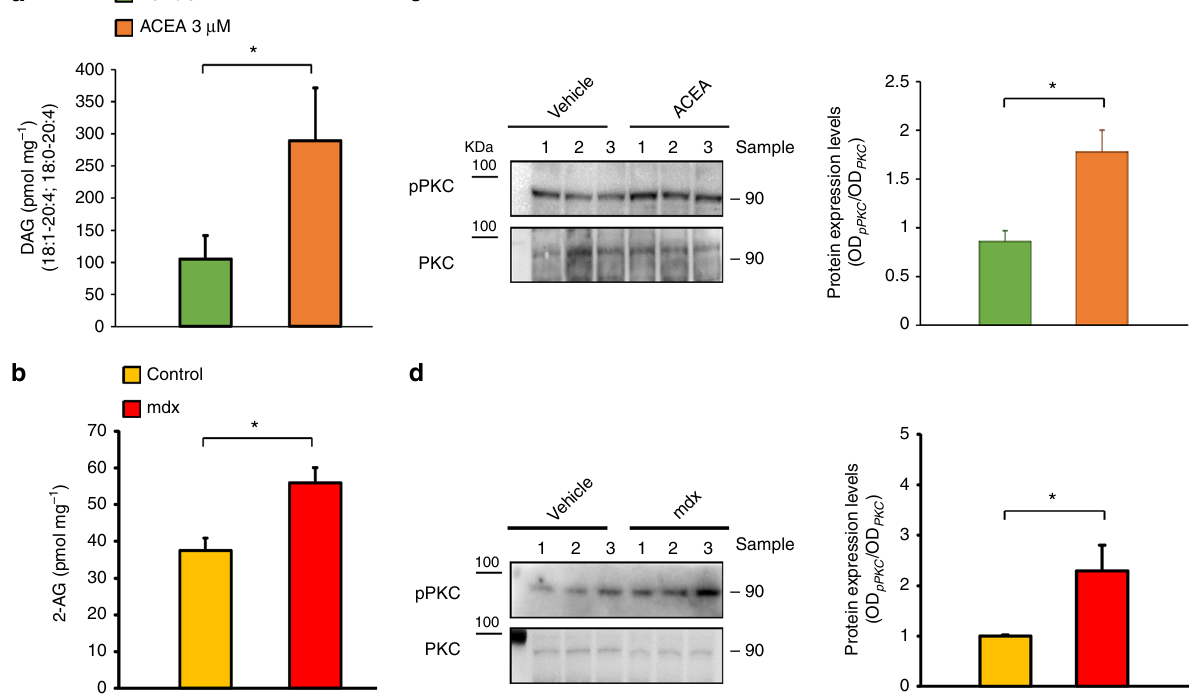
Fig. 9 Measurement DAGs levels and activity in satellite cells and muscles. Levels of diacylglycerols (DAGs) ( a ) and 2-AG ( b ), in primary satellite cells exposed to the selective CB1 agonist ACEA 3 µ M for 20 min. The levels of 2-AG and DAGs are normalized to the amount of lipids extract (pmol mg − 1 ). Each bar is the mean ± SEM of six separate determinations. * P ≤ 0.05 vs. vehicle group, determined by Student ’ s t test. c Representative blots showing